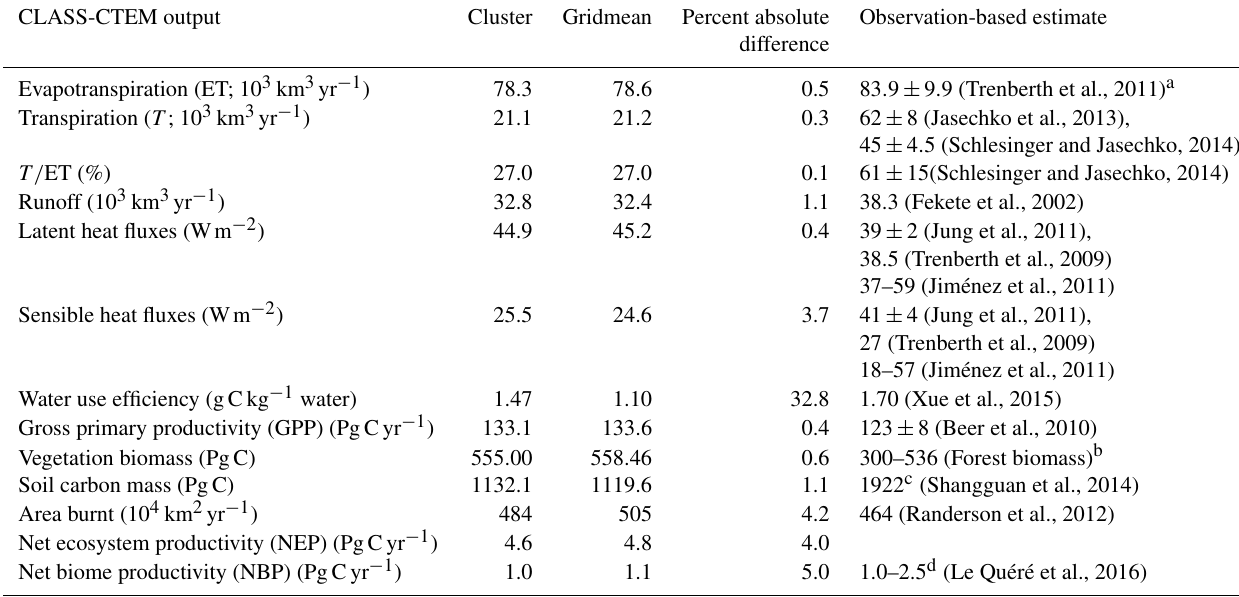
Table 1. Global annual values for CLASS-CTEM model outputs based on simulations using grid-mean soil textures (Gridmean) and tiled simulations derived from the clustering analysis (Cluster). Values are an average over the period